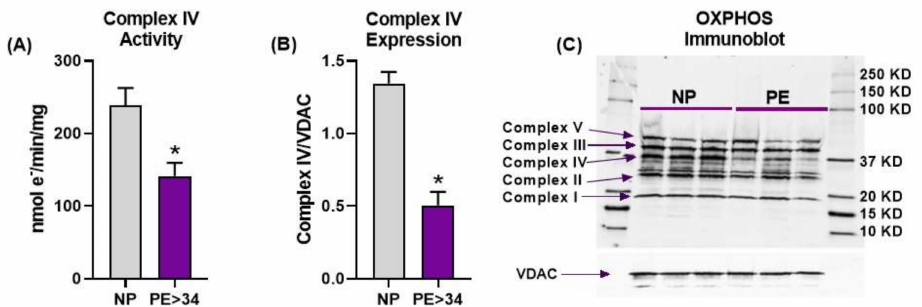
Figure 2. Placental mitochondrial electron transport chain (ETC) activity and expression. Oxygraph- 2K cytochrome C oxidase assay showed Complex IV activity was significantly reduced in placental mitochondria of late gestational age preeclamptic patients (PE > 34 weeks, n = 9; purple bar) vs. normal pregnant (NP, n = 10; gray bar) ( A ). Western blot analysis showed Complex IV expression ( n = 3) was significantly down regulated in placental mitochondria of late gestational age preeclamptic patients (PE > 34 weeks) vs. normal pregnant (NP, n = 3) ( B ). Immunoblotting performed using total OXPHOS cocktail antibody and voltage-dependent anion channel (VDAC, loading control) showing the protein bands for the ETC complexes ( C ). There was no difference observed in other complex expressions other than Complex IV between PE > 34 weeks vs NP. The results represent means ± SEM. * p < 0.05 vs. NP. e − , electron; KD, kilodalton; mg, milligram; min, minute; nmol, nanomole; SEM, standard error of